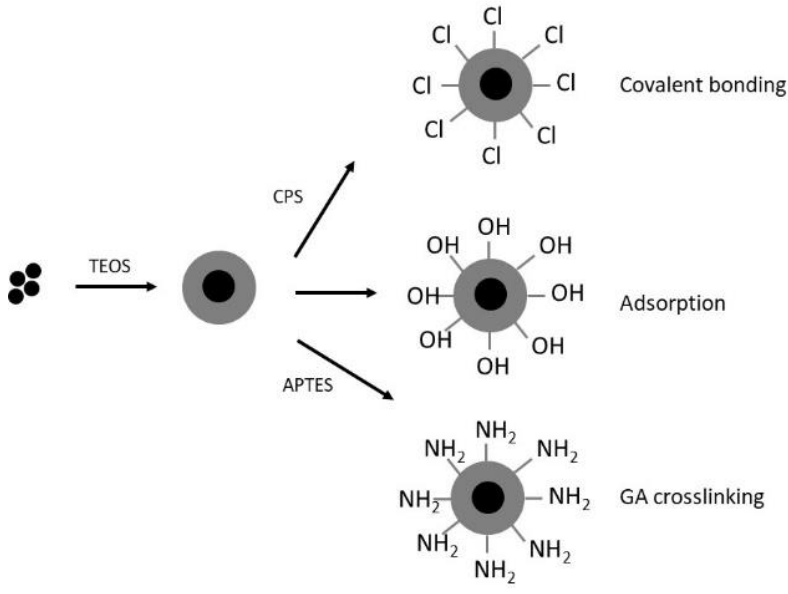
Figure 14. Preparation of Fe 3 O 4 @MCM-41/CPS for PPL covalent linking, Fe 3 O 4 @MCM-41 for PPL adsorption and Fe 3 O 4 @MCM-41/APTS for PPL cross-linking with GA.